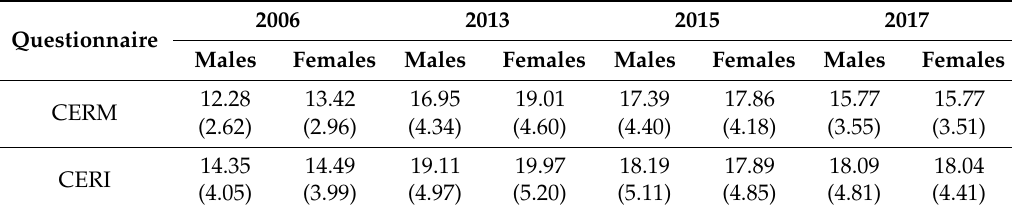
Table 6. Means and standard deviations (in brackets) of the CERM and the CERI scores.